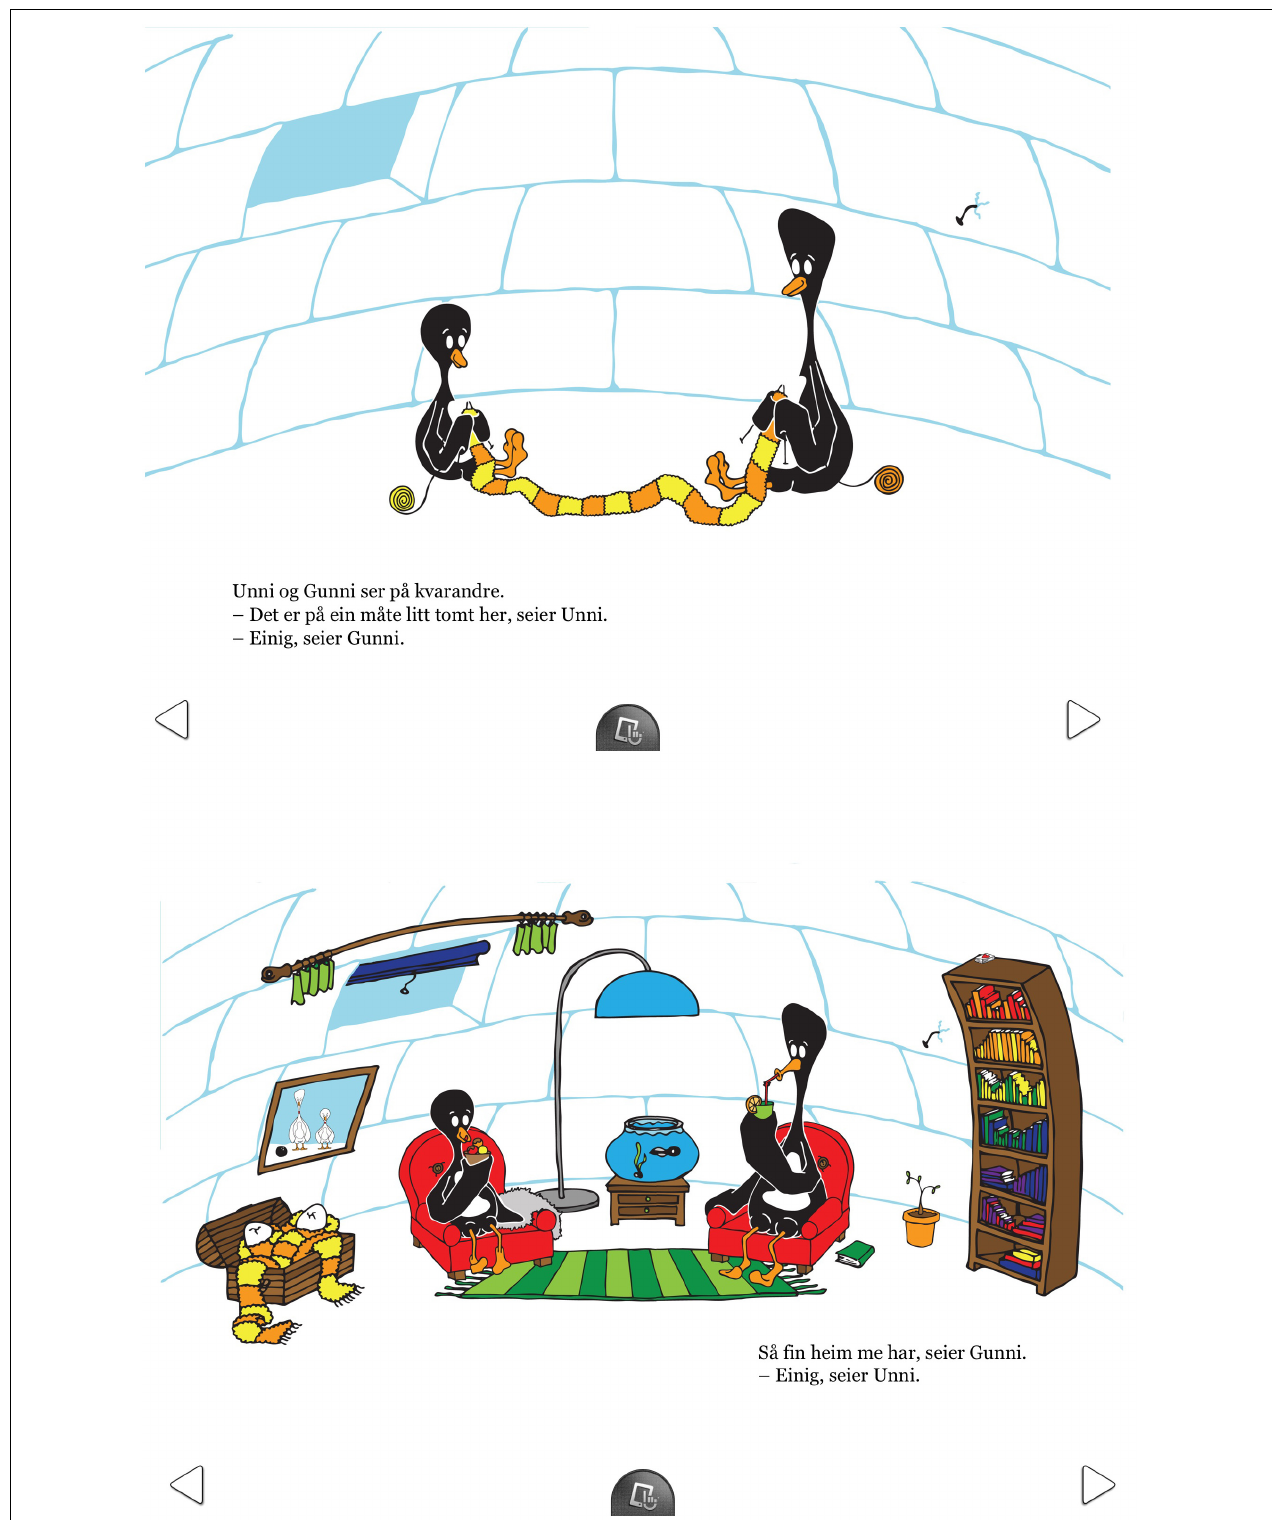
FIGURE 1 | The first and last screen in Unni og Gunni gjer det fint (2014). Reproduced with permission from Anna R. Folkestad and Det Norske Samlaget. The text reads: First screen: Unni and Gunni are looking at each other. “It is in a way a bit empty here,” Unni says. “Right,” Gunni says. Last screen: “We have such a nice home,” Gunni says. “Right,” Unni